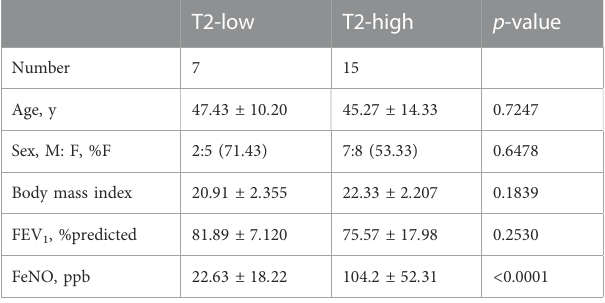
TABLE 3 Subject characteristics and bronchoscopic features by asthma